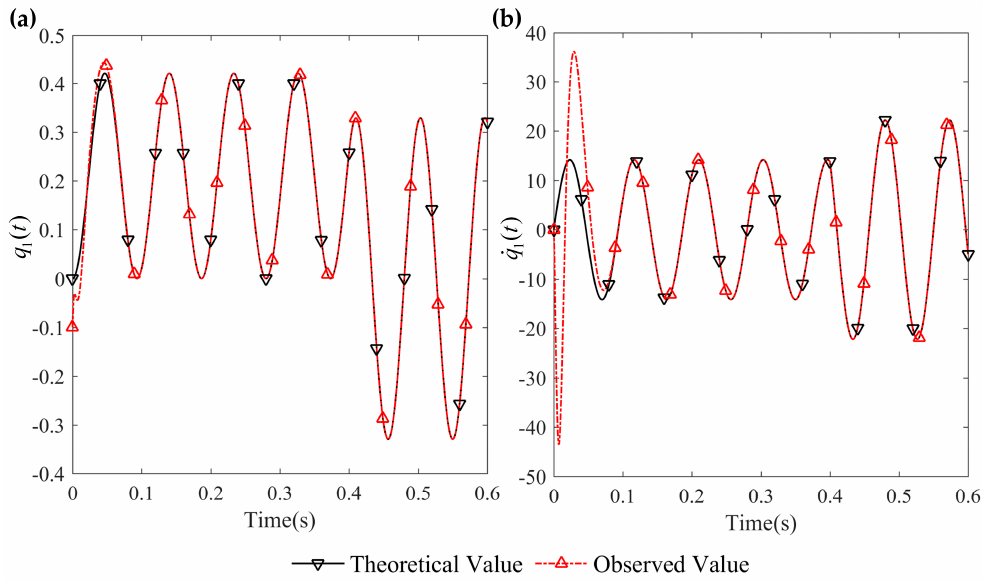
Figure 3. Tracking effect of the first-order mode and its derivative: ( a ) first-order mode tracking; ( b ) derivative of first-order mode tracking.